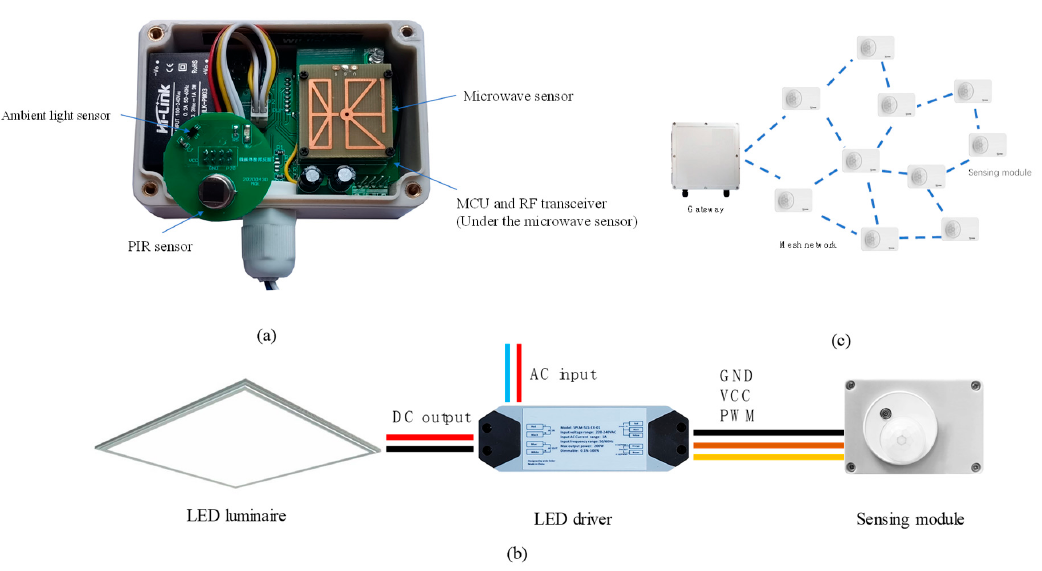
Figure 1. The architecture of the smart lighting system: ( a ) a wireless sensing module, ( b ) a LED luminaire controlled by a sensing module through LED driver, and ( c ) a wireless mesh network composed of sensing modules and a gateway.